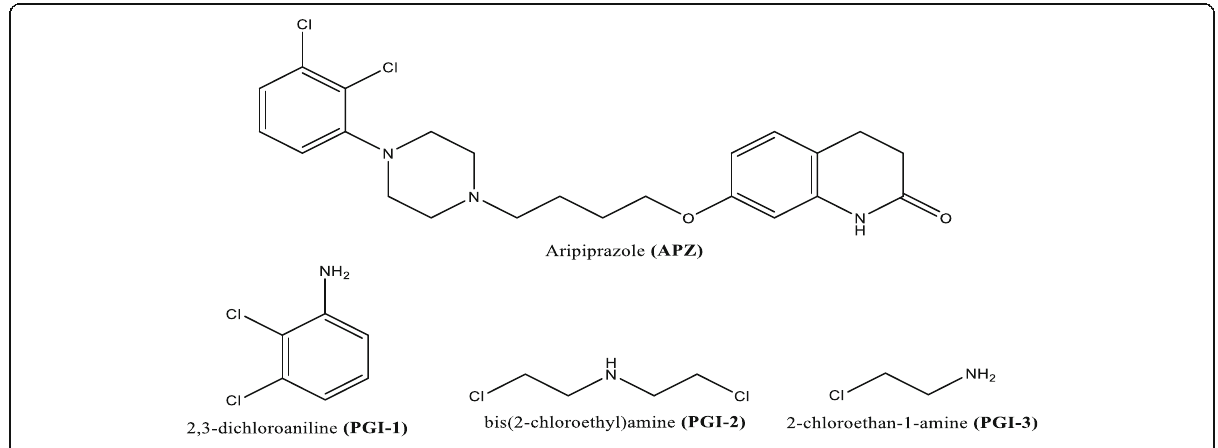
Fig. 1 Structures of aripiprazole and its potential genotoxic impurities